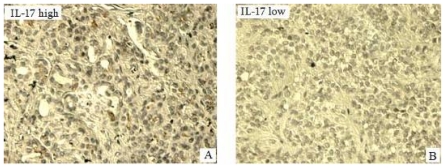
Expression of IL-17 in pancreatic tumors. IL-17+ cells stained brown and were present in tumor tissues and in corresponding adjacent normal tissues; (A) Representative immunostaining for high distribution of IL-17+ cells is shown in pancreatic tumors (original magnification 400×); (B) Representative immunostaining for low distribution of IL-17+ cells is shown in corresponding adjacent normal tissues (original magnification 400×).